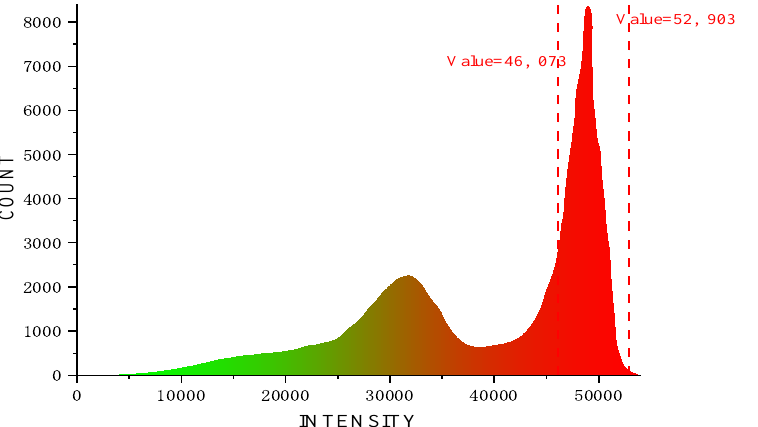
Figure 18. Selecting a range of intensity values of the laser point clouds of Figure 17 for segmentation.